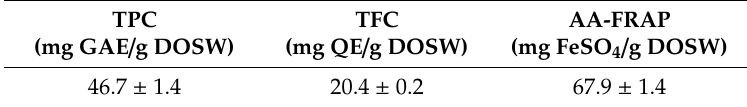
Table 1. Experimental results for the conventional extraction experiments.